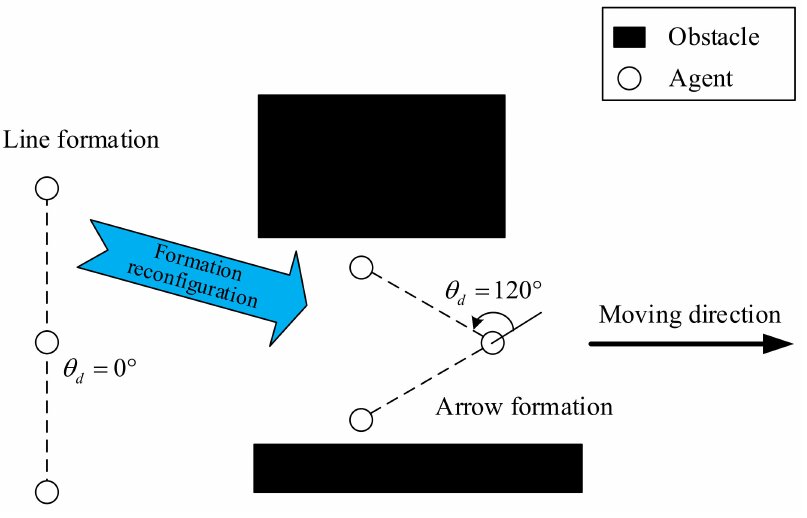
Figure 4. Formation reconfiguration